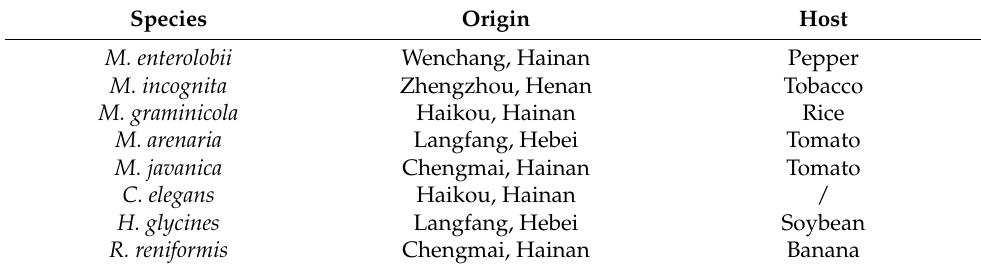
Table 3. The sources of Meloidogyne spp. and other nematodes selected in this study. Species Origin